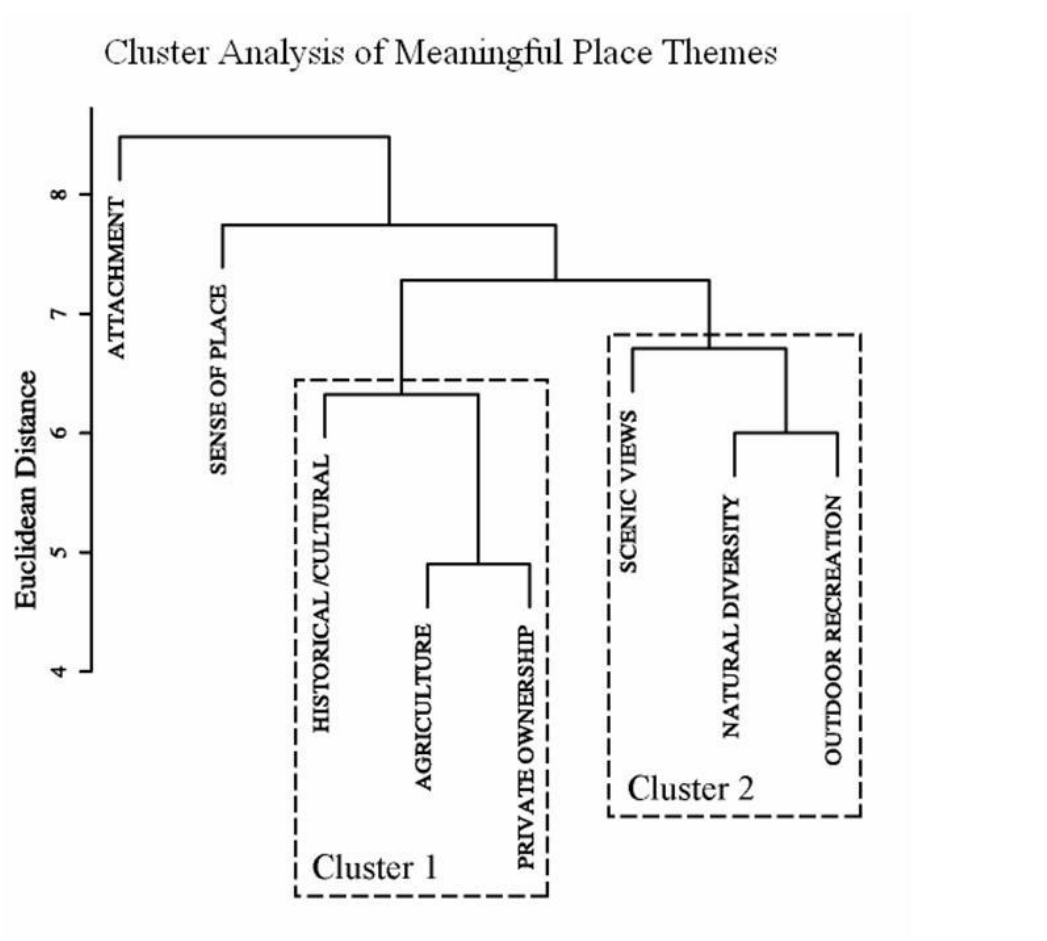
Fig. 4 . Dendrogram of cluster analysis for meaningful place themes from 90 semistructured interviews with Palouse-area landowners and stakeholders. Clusters show distinct groupings of characteristics likely to be associated with particular meaningful